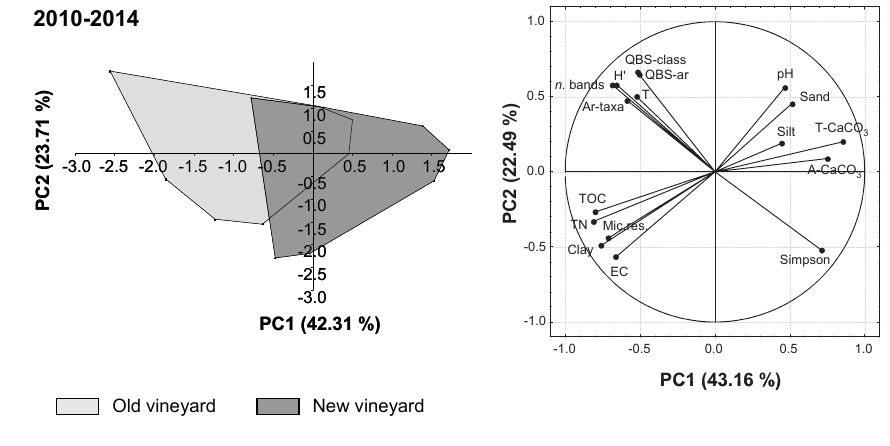
Figure 10. PCA score and loading plots for the whole 2010–2014 period (including